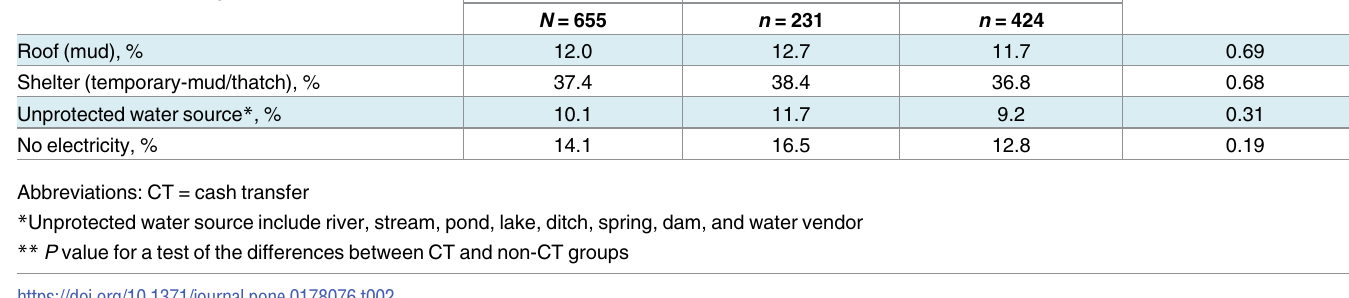
Table 2. Comparison of proxies for socioeconomic status or poverty level among CT and non-CT households contributing participants to the study. Poverty